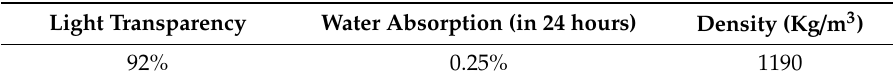
Table 4. Properties of acrylic. Light Transparency